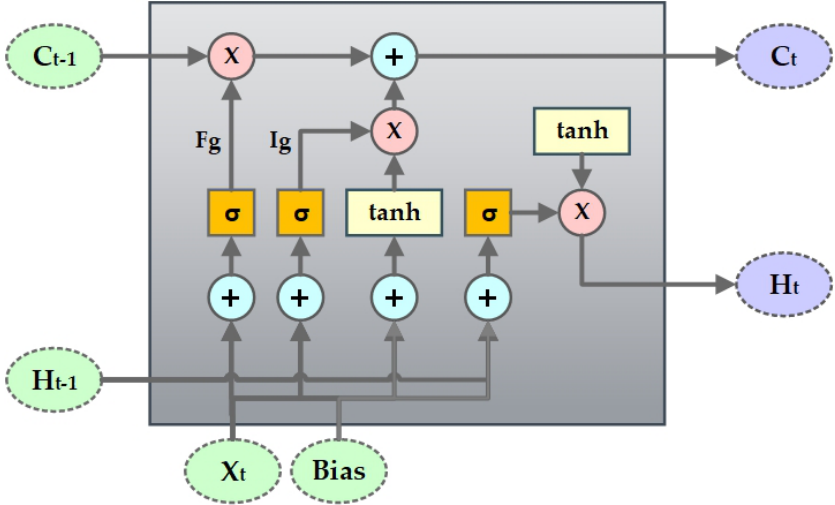
Figure 4. Long Short-Term Memory (LSTM)